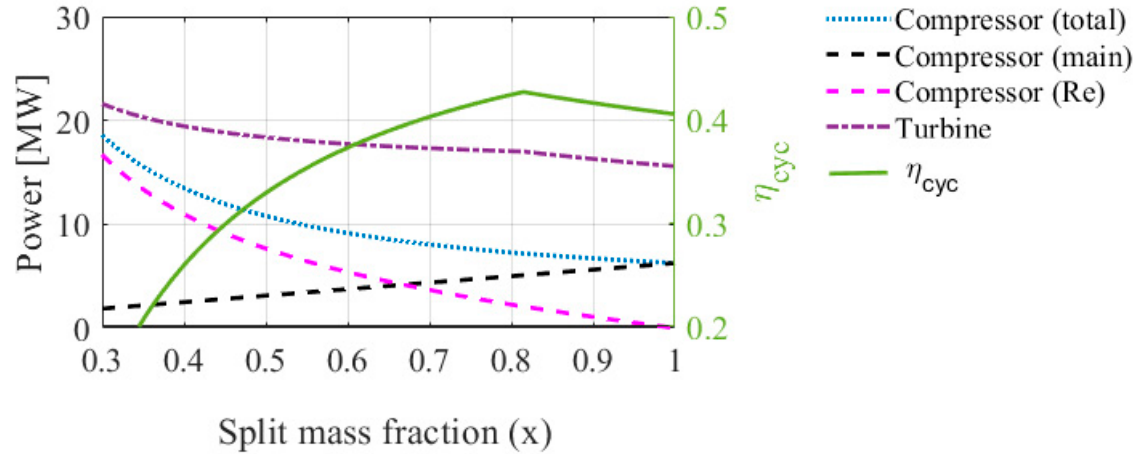
Figure 4. Impacts of the split mass fraction on the cycle and its modules.